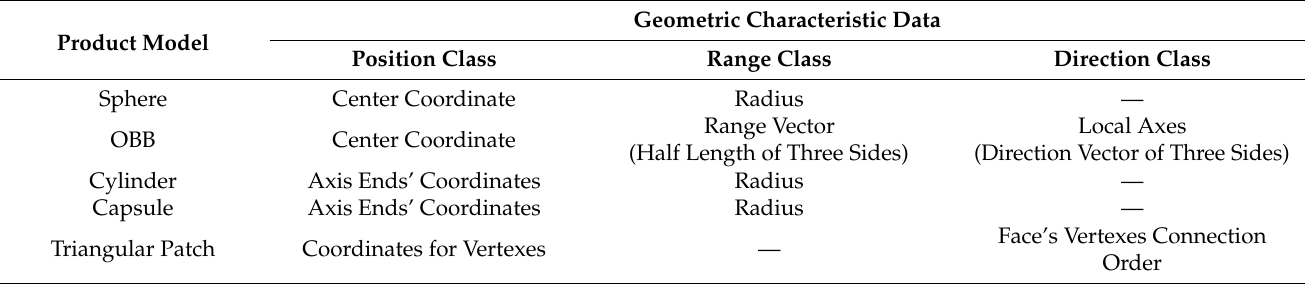
Table 2. Necessary Geometric Characteristic Data of Different Product